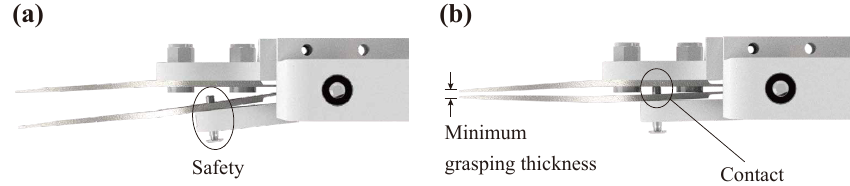
Figure 3. ( a ) Safety structure to prevent excessive grasping force. The bolt is assembled with the rotating part of the device. ( b ) When the device grasps the tissue, the grasping thickness is limited because the safety bolt contacts the opposite forceps body and prevents further rotation. The minimum grasping thickness can be precisely adjusted by turning the bolt.